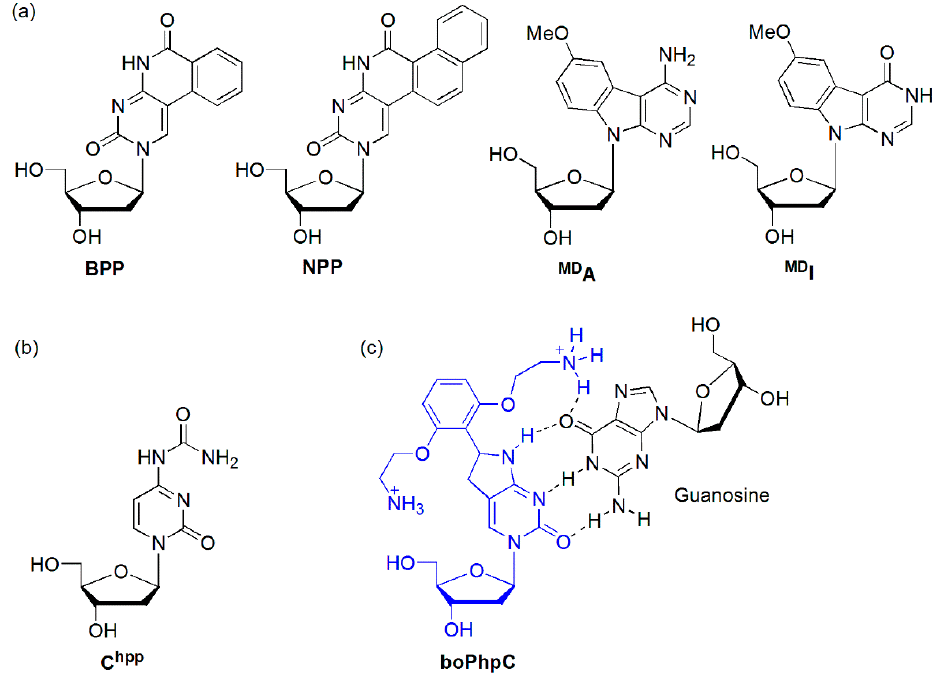
Figure 6. ( a ) BPP, NPP, MD A, and MDI , ( b ) C hpp , and ( c ) boPhpC.